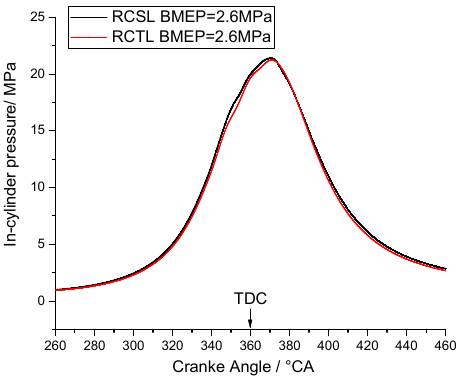
Figure 12. Cylinder pressure for two combustion chambers at BMEP2.6 MPa load.